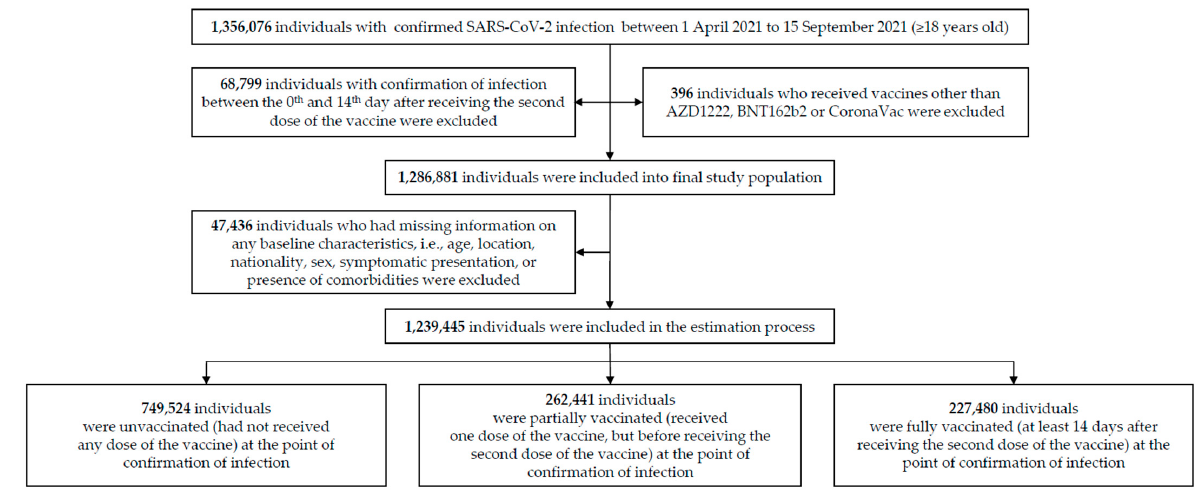
Figure 1. Study participants and cohort eligibility. Cohort participants were all confirmed SARS ‐ CoV ‐ 2 cases in Malaysia from 1 April 2021 to 15 September 2021, aged 18 years or older. All participants either had not received any (unvaccinated) or at least one dose of the AZD1222, BNT162b2, or CoronaVac vaccines. Individuals who received any vaccines other than the ones specified above were excluded from the cohort.